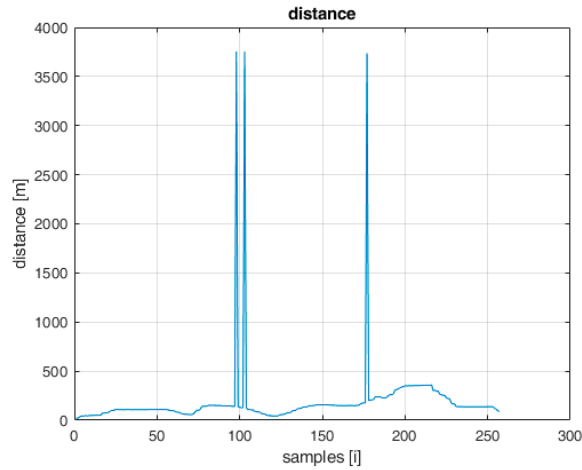
Figure 2. Distance to the UAV measured by AeroScope system.